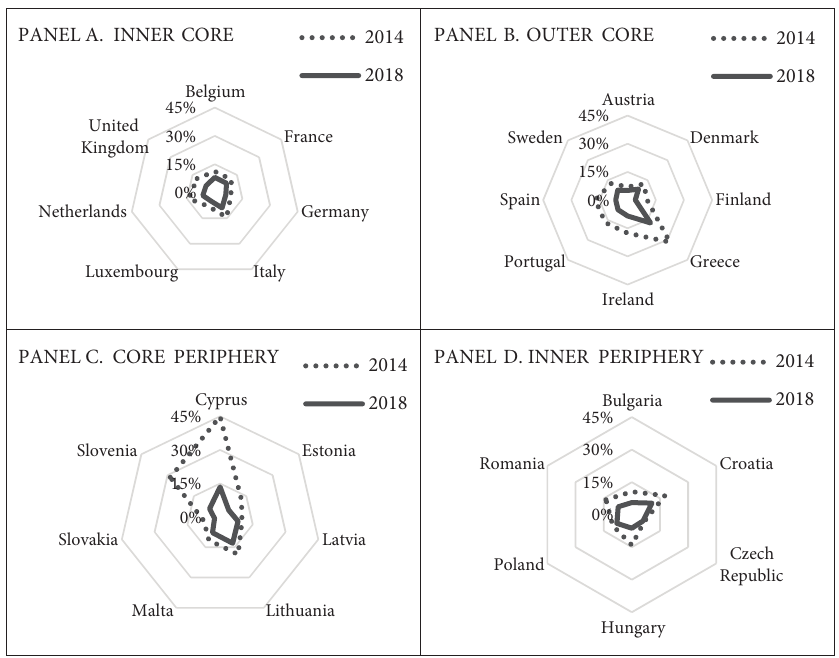
Figure 2. The percentage of surveyed SMEs that pointed on access to finance as one of most important problem currently